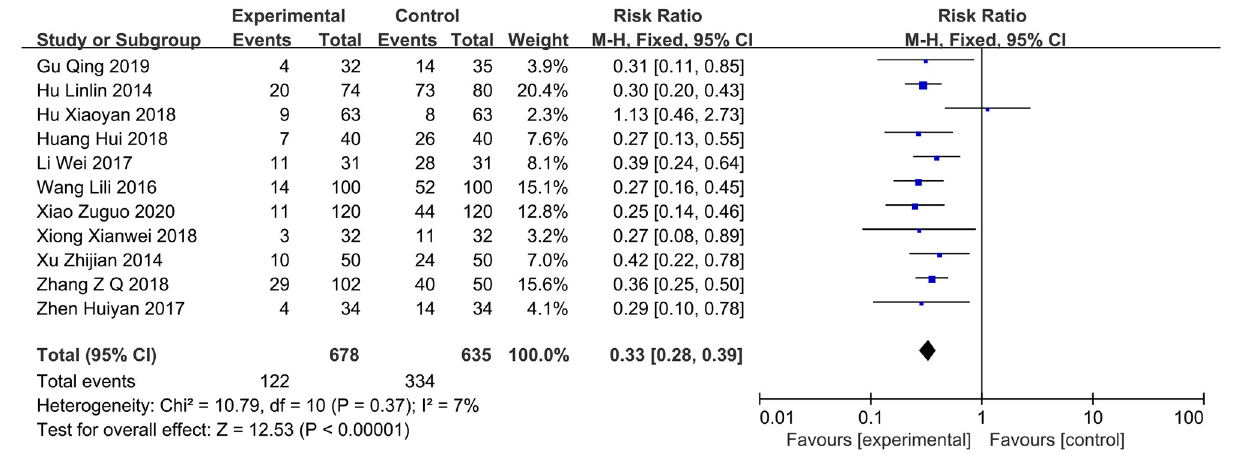
FIGURE 6 | Forest plot of the incidence of other adverse reactions between the PPI treatment group and the conventional treatment group. PPI, proton-pump inhibitor.